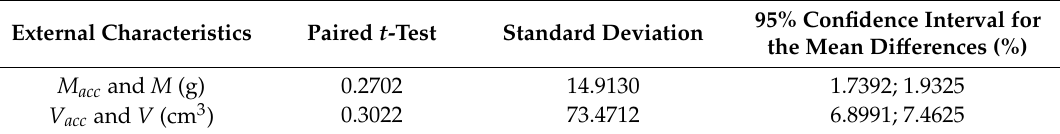
Table 3. Paired t -test analyses between measured values and estimated values of external characteristics. Table 3. Paired t-test analyses between measured values and estimated values of external External Characteristics characteristics.